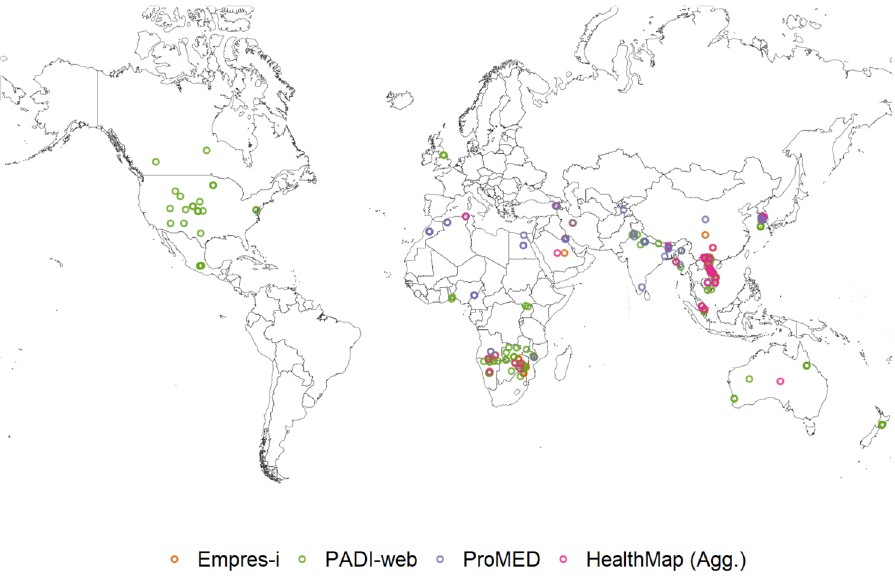
Fig 4. Foot-and-mouth disease (FMD) outbreaks reported in Empres-i and FMD relevant signals detected by PADI-web, ProMED and HealthMap (Agg.) from January to June